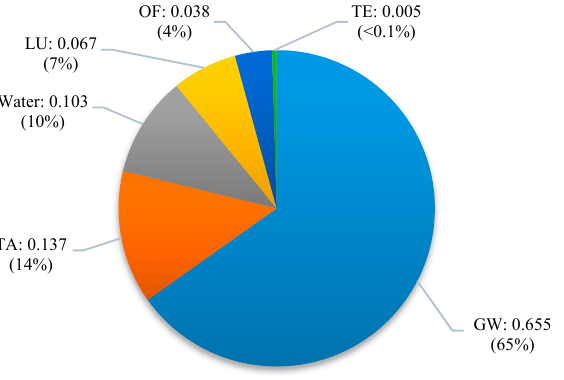
Figure 3. Terrestrial ecosystem damage (PDF m 2 y / kg) from the production of 1 kg of sol-gel coating, based on the hierarchist perspective. Global warming (GW), ozone formation (OF), terrestrial acidification (TA), terrestrial ecotoxicity (TE), land use (LU).